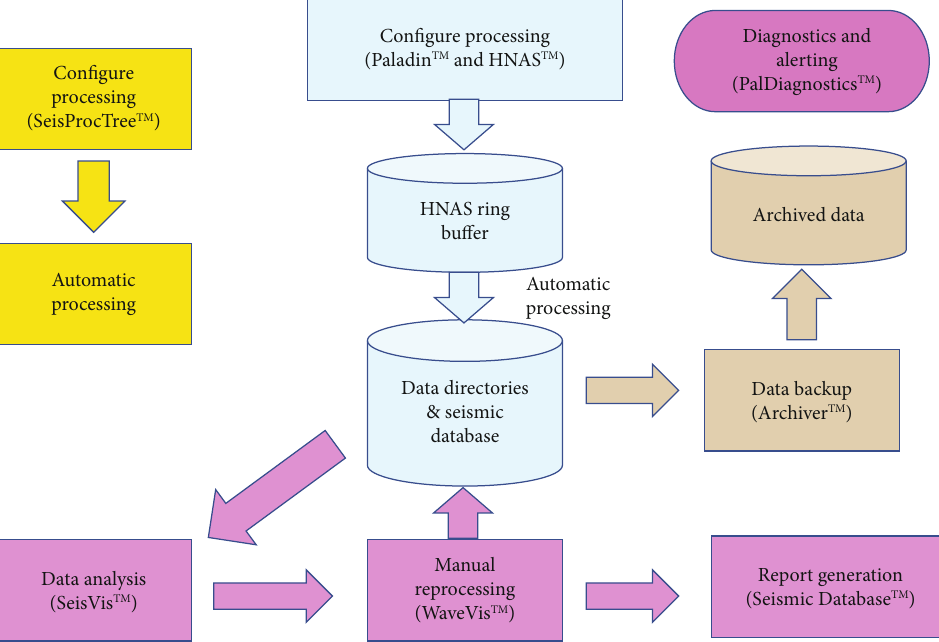
Figure 15: ESG microseismic monitoring system analysis module.